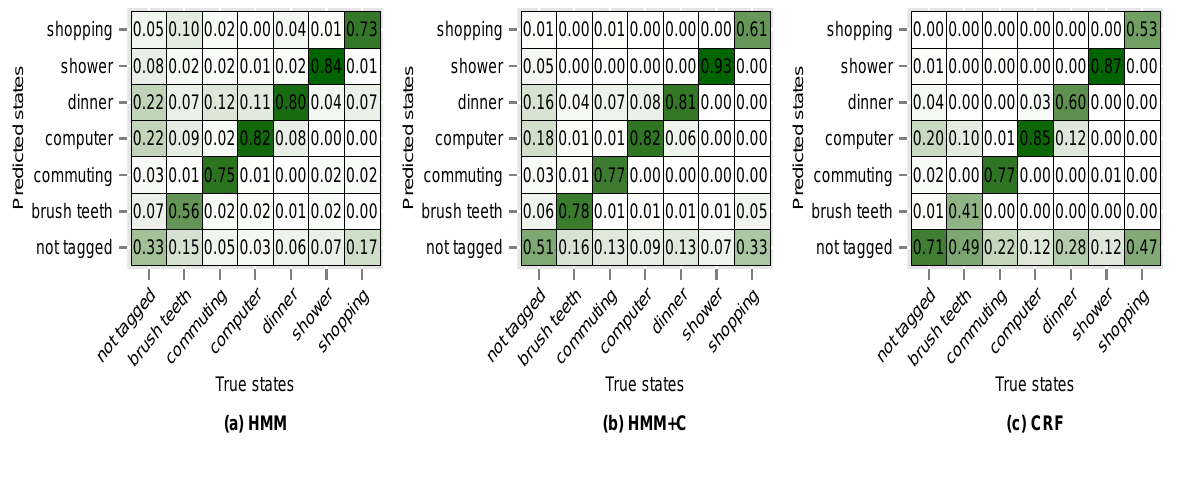
Figure 11. Confusion matrices for experiment 3 (subject 1): silhouette